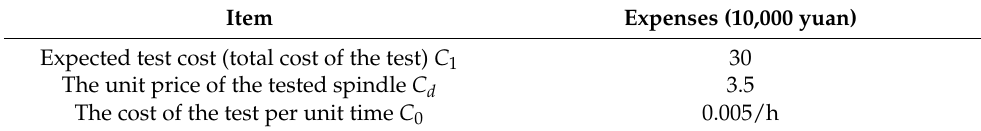
Figure 5. The Actual test equipment of motorized spindle. Table 5. Expected test cost and ADT